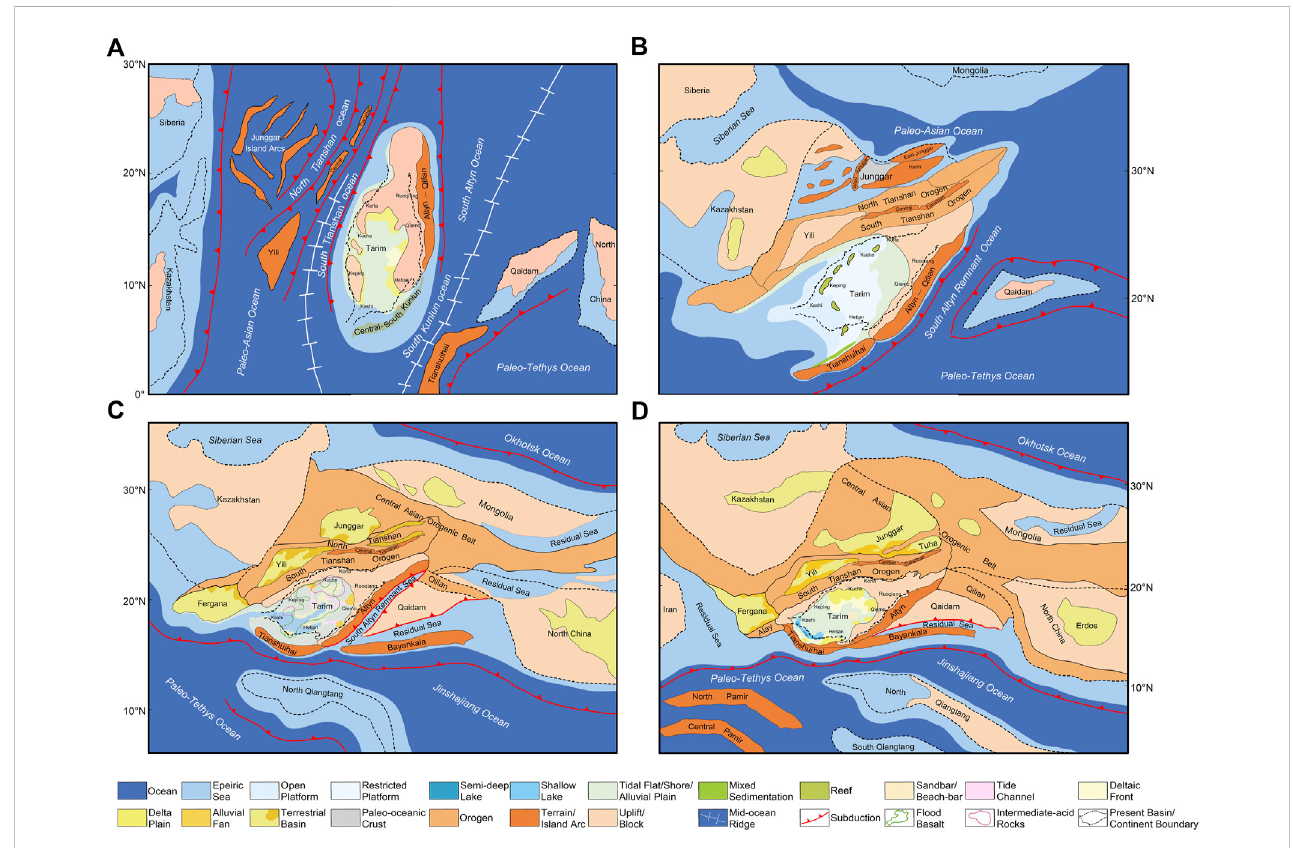
FIGURE 9 Tectono-paleogeography of Tarim and adjacent areas in late Devonian (A) , late Carboniferous (B) , late Middle Permian (C) and late Permian (D)